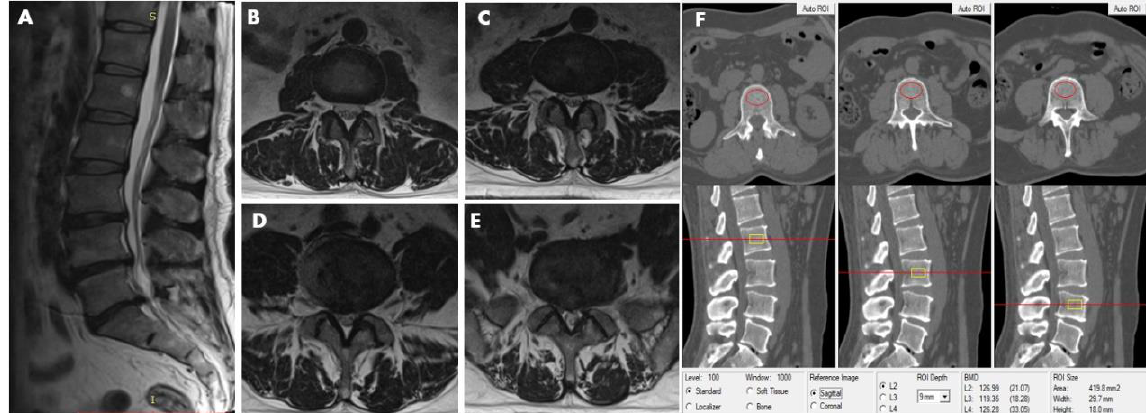
Figure 3. This 48-year-old male participant was assigned to the LDH group and subgroup 2, simultaneously. MRI (T2- weighted image) revealed lumbar disc herniation condition from L2–3 to L5—S1disc. ( A ) Sagittal image revealed lumbar disk herniation in L3–4, L4–5, and L5–S1. ( B ) L2–3 axial image shows no abnormality in disc morphology. ( C ) L3–4 axial image shows focal protrusion at the central canal zone with a high-intensity zone (HIZ). ( D ) L4–5 axial image shows broad-based protrusion at posterolateral or dorsally, decreasing the diameter of the spinal canal and the foramen. (E) L5/S1 axial image shows asymmetric bulge companion with a focal protrusion, the right normal epidural fat layer between the two is not evident (at least the contact). ( F ) The measurements of L2, L3, and L4 vertebral trabecular volumetric bone mineral density (Trab.vBMD) are shown; the BMD of L2, L3, and L4 is 126.99 mg/cm 3 , 119.35 mg/cm 3 , and 126.28 mg/cm 3 , respectively; the average lumbar Trab.vBMD is 124.21 mg/cm 3